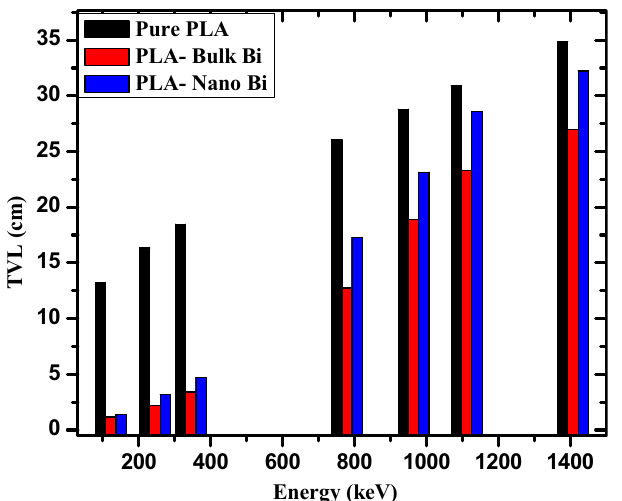
Figure 5. The TVL for the pure PLA, PLA with bulk Bi, and PLA with nano Bi at different energies.